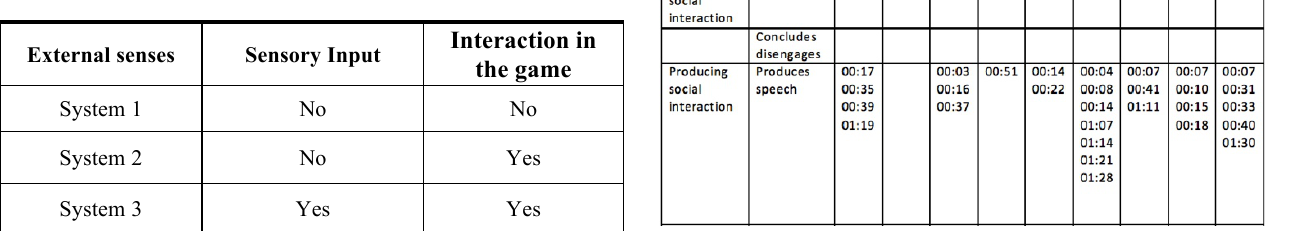
Table 5. Three different testings for the evaluation